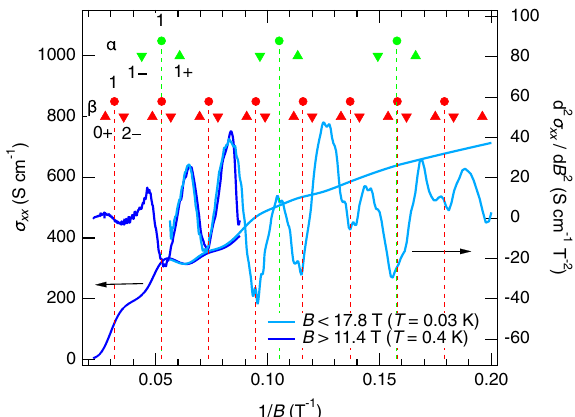
Fig. 3 Shubnikov-de Haas oscillations and Landau-level crossing fi elds. The longitudinal conductivity in CaFeAsF and its second fi eld derivative are shown as a function of 1/ B . The green (red) triangles indicate the Landau-level crossing fi elds for α ( β ) based on Fig. 1d. The hypothetical spinless crossing fi elds (i.e, without Zeeman energy) are also indicated by circles. The labels attached to marks are the Landau index (0, 1, etc.) and spin species ( + / − or none).